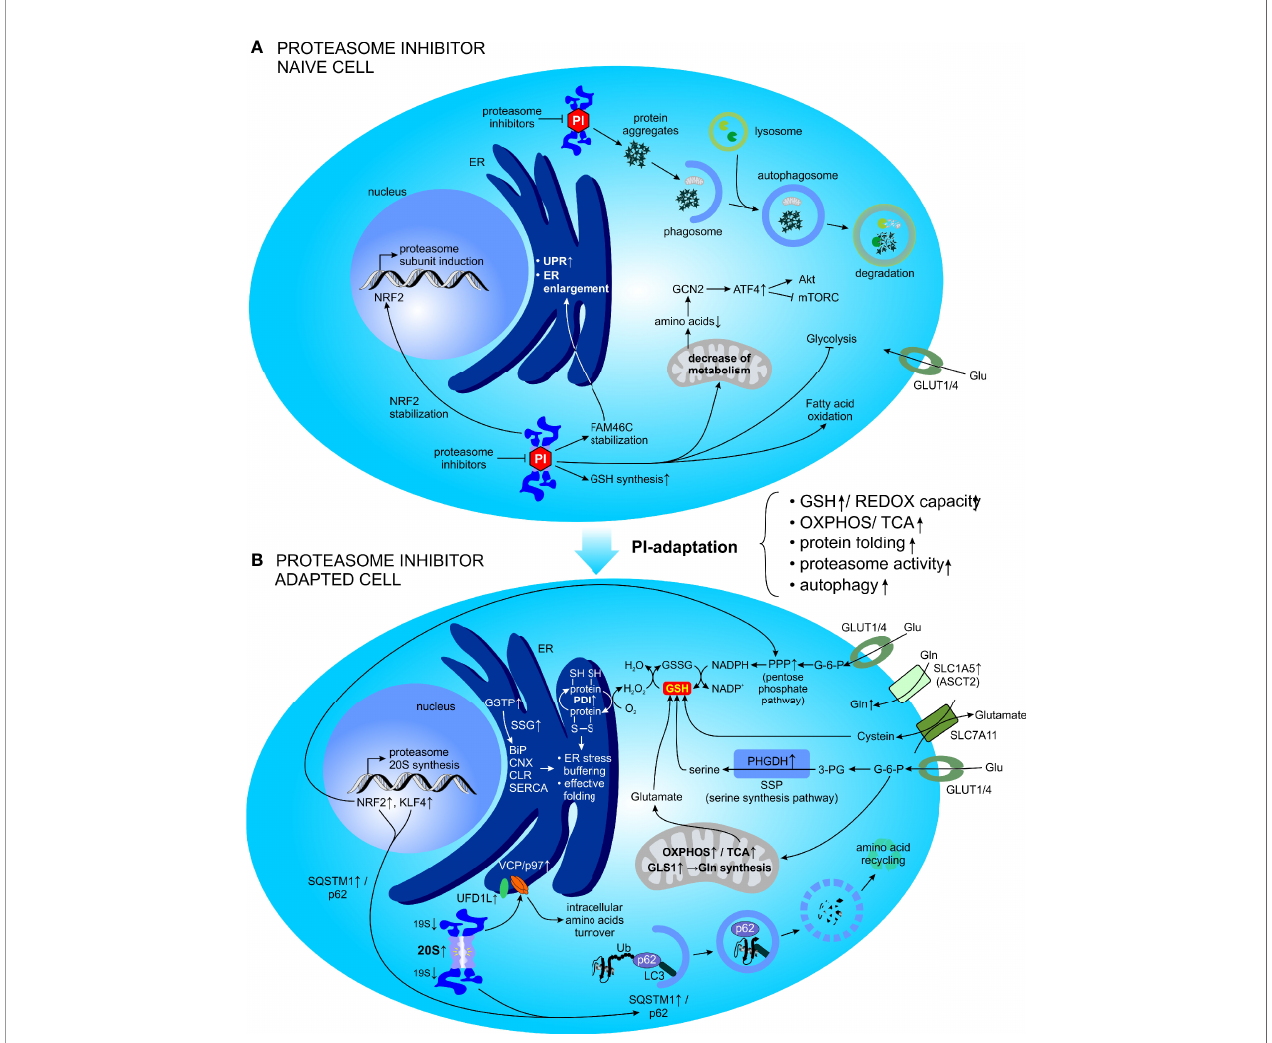
FIGURE 5 | Metabolic factors promoting resistance to PI in MM. (A) Adaptive cellular responses following acute and short-term PI treatment. (B) Global cellular adaptation towards PI treatment (emerging as the PI resistance). ATF4, activating transcription factor 4; BiP, binding immunoglobulin protein; CLR, calreticulin; CNX, calnexin; ER, endoplasmic reticulum; FAM46C, family with sequence similarity 46 member C; G-6-P, glucose-6-phosphate; GCN2, general control nonderepressible 2; Gln, glutamine; GLS, glutaminase; Glu, glucose; GLUT, glucose transporter; GSH, glutathione (reduced); GSSG, glutathione (oxidized); GSTP, Glutathione S-transferase P; KLF4, kruppel like factor 4; LC3, protein light chain 3; mTORC, mechanistic target of rapamycin complex 1; NAD(P)+/H, nicotinamide adenine dinucleotide (phosphate) oxidized/reduced); NRF2, nuclear factor erythroid 2-related factor 2; OXPHOS, oxidative phosphorylation; PDI, protein disul fi de isomerase; 3-PG, 3-phosphoglyceric acid; PHGDH, phosphoglycerate dehydrogenase; PI, proteasome inhibitor; PPP, pentose phosphate pathway; REDOX, reduction – oxidation; SERCA, sarco/endoplasmic reticulum Ca2+-ATPase; SLC1A5, solute carrier family 1 member 5; SLC7A11, solute carrier family 7 member 11; SSG, S-glutathionylation; SSP, serine synthesis pathway; SQSTM1, sequestosome 1; TCA, tricarboxylic acid; Ub, ubiquitin; UFD1L, ubiquitin recognition factor in ER associated degradation; UPR, unfolded protein response; VCP, valosin-containing